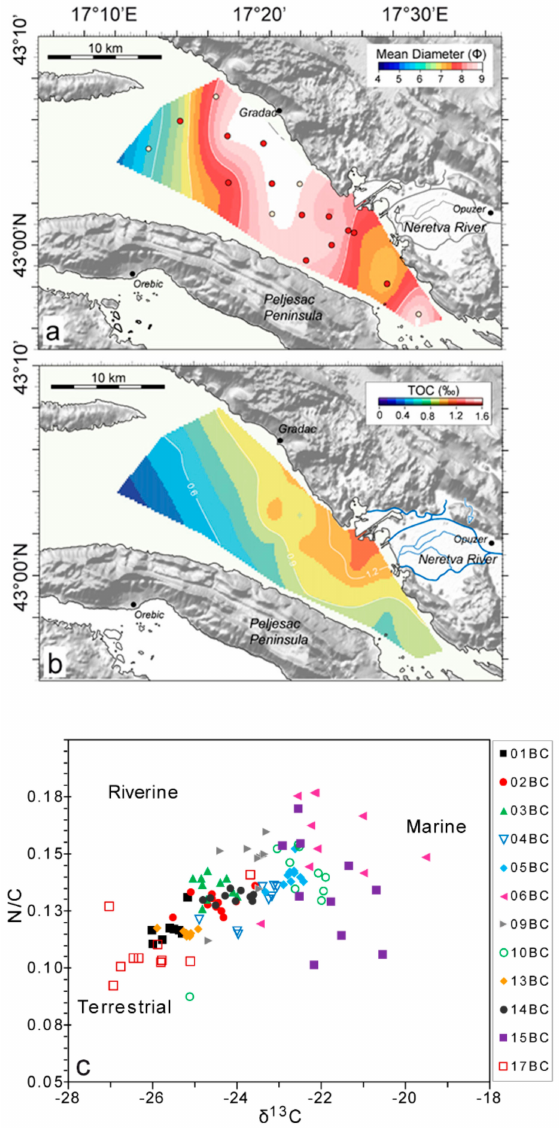
Figure 2. ( a ) Log-normal sediment mean diameter [38] areal distribution and ( b ) organic carbon surficial areal distribution in the Neretva Channel with ( c ) covariation of N / C versus δ 13 C. Surficial TOC (Figure 2b) varies from 0.6% (06BC) to 1.18% (17BC) and δ 13 C from -22.3% (cid:24) (06BC) to -27.0% (cid:24) (17BC). Total nitrogen (TN) content ranges from 0.15% (17BC) to 0.09% (06BC), resulting in C / N ratios from 5.9 to